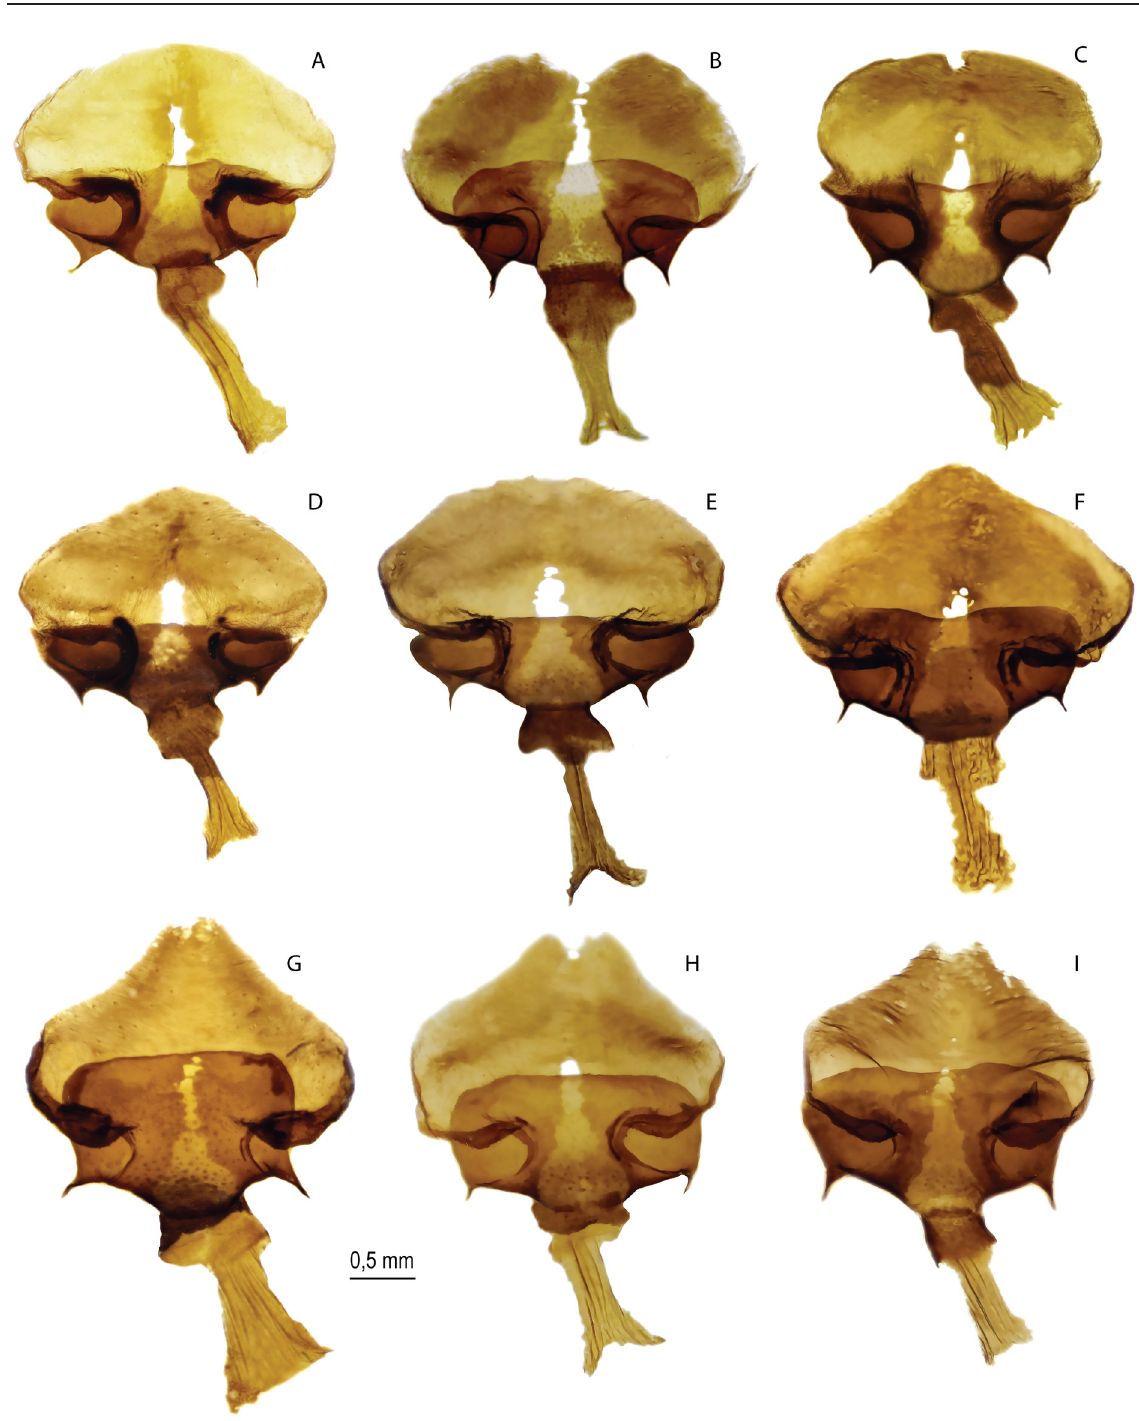
Fig. 4. Female genitalia (without the anal papillae, copulatory bursa, and anterior and posterior apophyses). A–D . M . shahvarica sp. nov., Iran, Semnan Prov., Shahrud area, S macroslope of